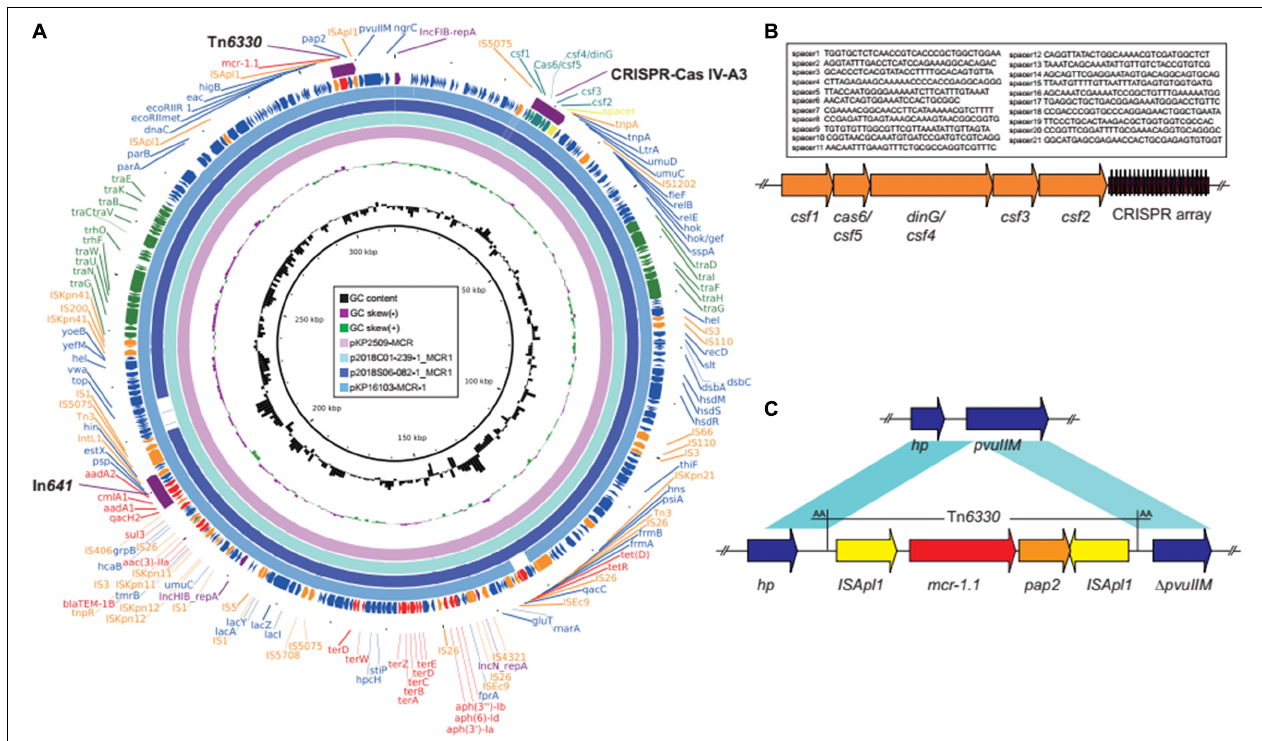
FIGURE 1 | (A) Plasmid structure of mcr -1 and CRISPR-Cas co-harboring plasmids. Colored arrows indicate open reading frames, with purple, orange, green, red, teal, and blue arrows representing replication genes, mobile elements, plasmid transfer genes, the antimicrobial and heavy metal resistance gene, CRISPR-Cas, and plasmid backbone genes, respectively. (B) The CRISPR-Cas IV-A3 region in pKP2509-MCR. (C) The mcr-1 -harboring Tn 6330 and neighboring genes in pKP2509-MCR. Blue shading denotes regions of shared homology among different elements. hp , hypothetical protein gene.